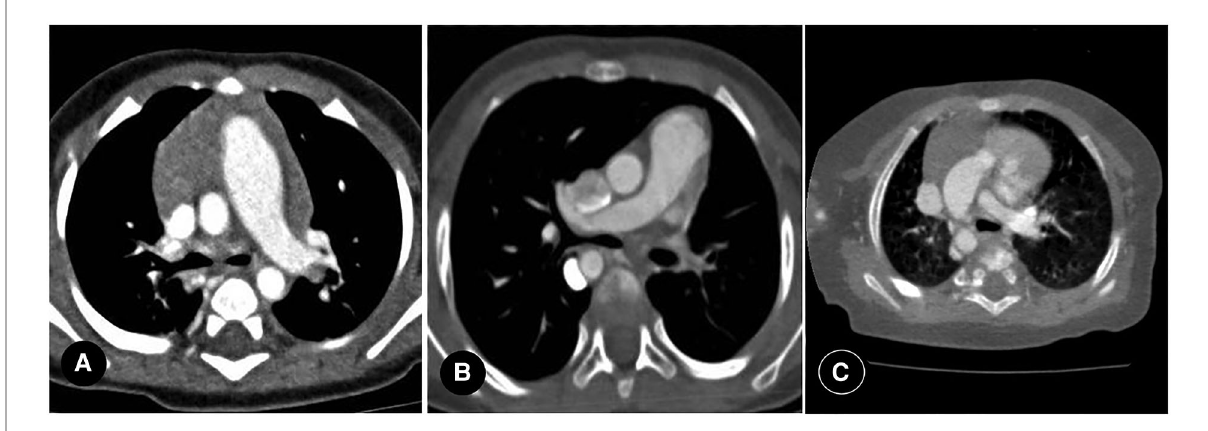
con fl uence, and a left-sided hilar artery. The left internal pulmonary artery branches are open. Right-sided aortic arch. ( C ) right PIPA with a right- sided aortic arch in a 6-month-old male patient. A transverse view of the CCTA shows the absence of the right pulmonary artery with a right- sided aortic